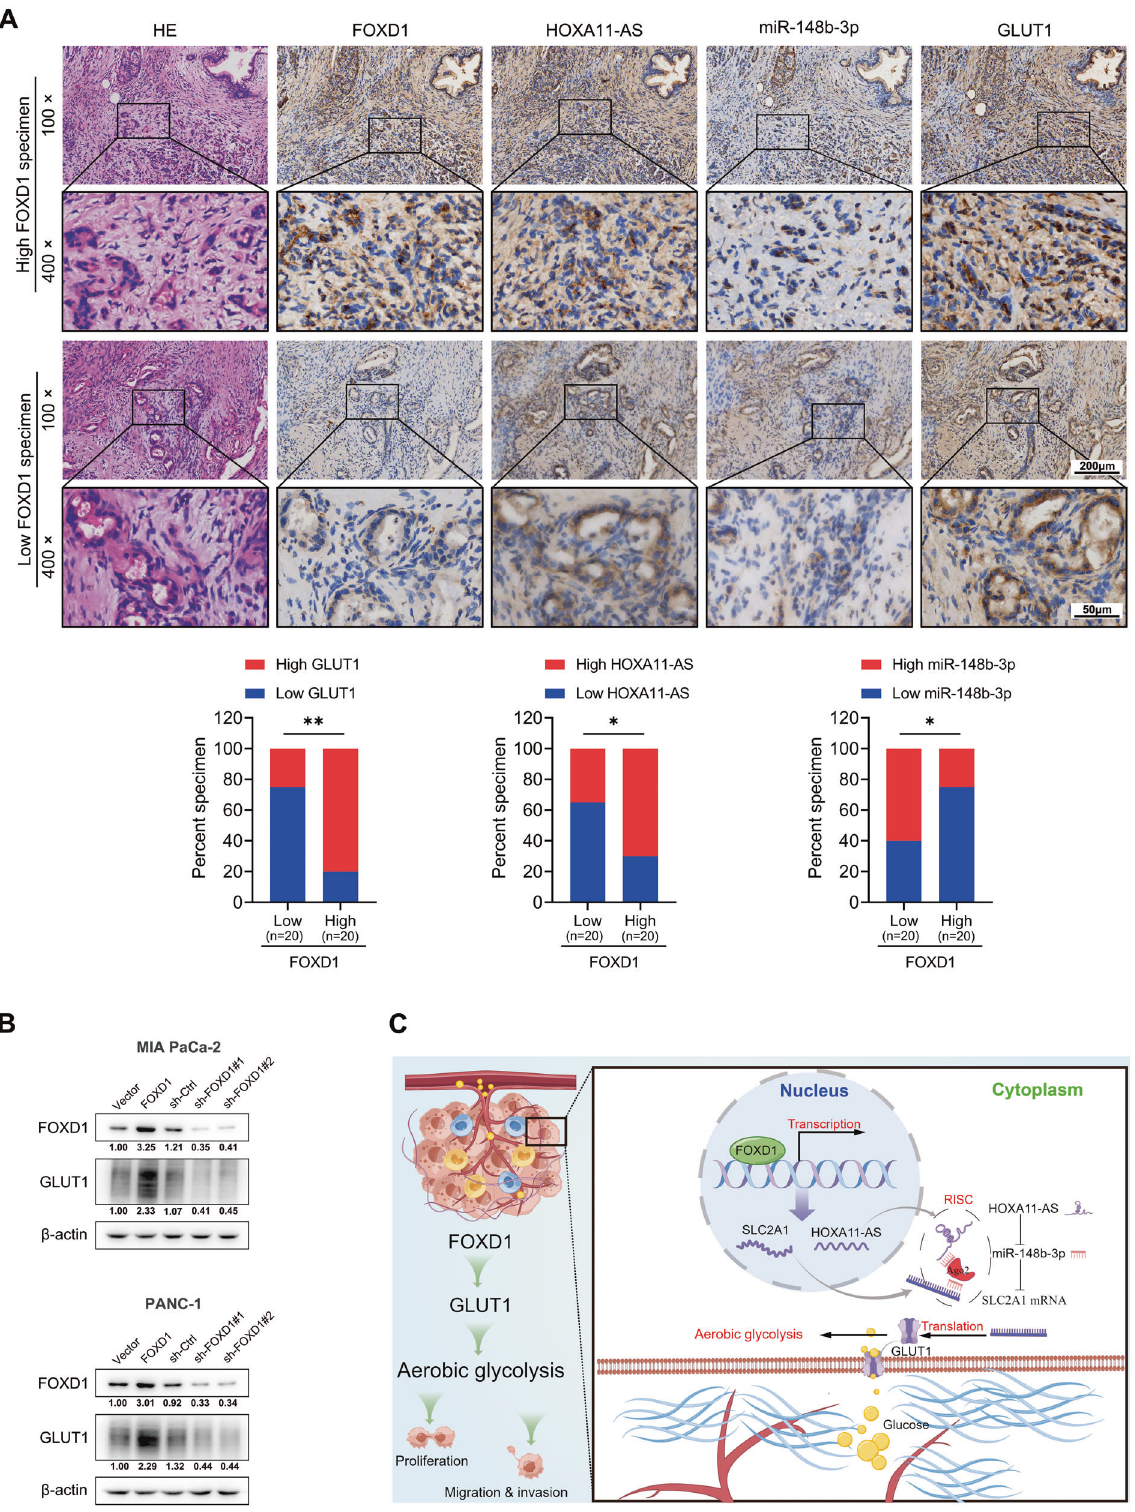
Fig. 7 FOXD1 expression correlates with GLUT1 in PC. A Representative image of FOXD1, HOXA11-AS, miR-148b-3p, and GLUT1 expression in serial sections of pancreatic cancer specimens detected through IHC and ISH. Pearson ’ s chi-squared test of the expression of 40 specimens. B GLUT1 expression of MIA PaCa-2 and PANC-1 cells with FOXD1 overexpression and knock-down were detected using western blotting. C Illustration of how FOXD1 facilitates pancreatic cancer cell proliferation, invasion, and metastasis by regulating GLUT1-mediated aerobic glycolysis, created by Figdraw (http://www. fi gdraw.com). * p < 0.05; ** p < 0.01.